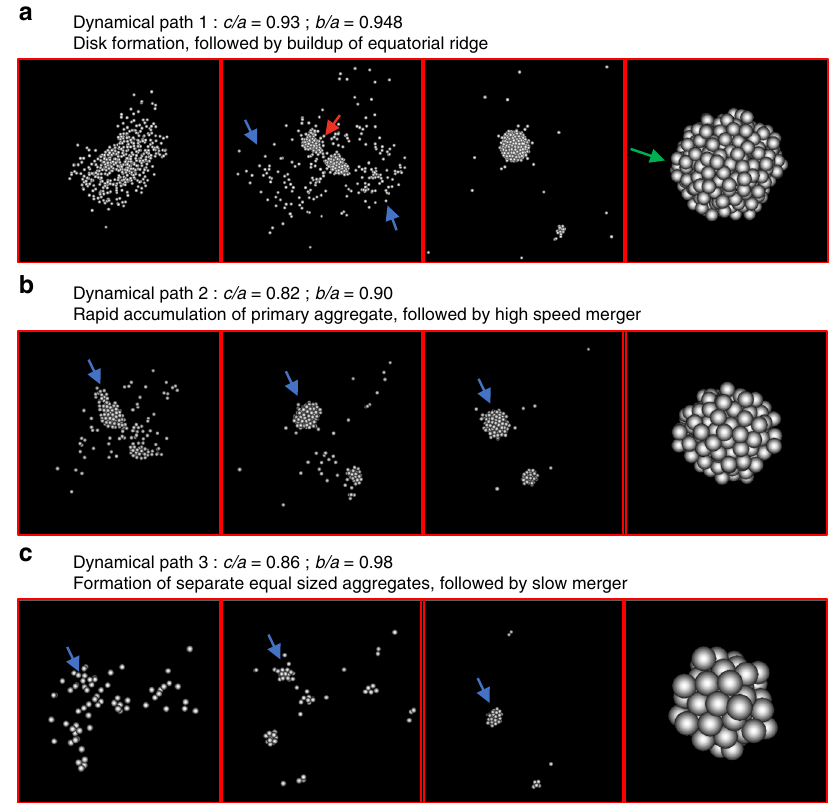
Fig. 4 Multiple dynamical paths lead to the formation of oblate spheroids. Snapshots of three cases of the gravitational reaccumulation of those smaller aggregates are in panels ( a – c ). Simulations snapshots at time steps 1 min, 0.75 h, 2 h, and 5 h after the collision, separated by red lines, are given for each dynamical path presented in panels ( a – c ). The fi rst panel of each case shows the immediate distribution of the particle that reaccrete to form the fi nal aggregate shown in the last panel of the same case. a Path 1 shows the ejection of a material stream that forms an elongated disk (blue arrows) with a dense core (red arrow). The disk of material then accretes onto the equator, spinning up the core through conservation of angular momentum and building up a ridge (green arrow). Paths 2 and 3 ( b , c ) show the formation of oblate spheroids through the collapse of multiple cores that subsequently coalesce. b For path 2, the aggregates have a high enough relative speed that the smaller bodies break up on impact and individual particles accrete onto the larger body (blue arrow) isotropically. c For path 3, a kind of nucleation occurs, where a large primary aggregate quickly forms out of the merger (blue arrow) and becomes the focus point of a gradual deposition of smaller aggregates that accrete isotropically, slowly building up an oblate spheroid (see Supplementary Movies 3 – 5 of these three